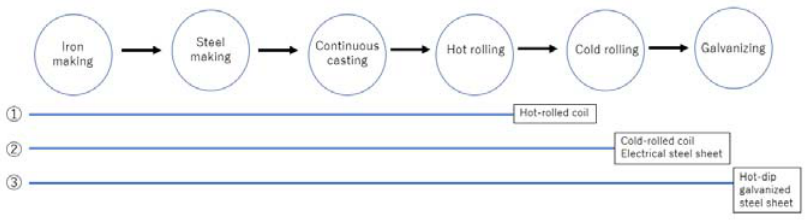
Figure 1. Expansion of steel manufacturing